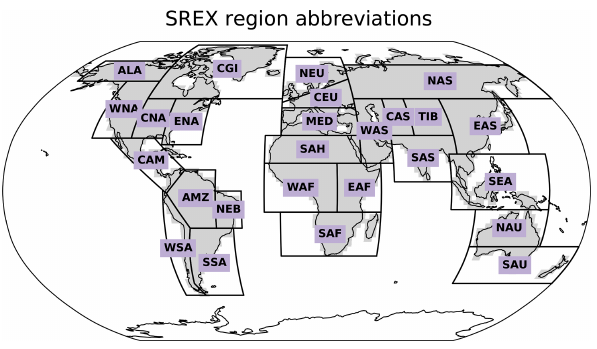
https://doi.org/10.5194/esd-13-851-2022 Earth Syst. Dynam., 13, 851–877,